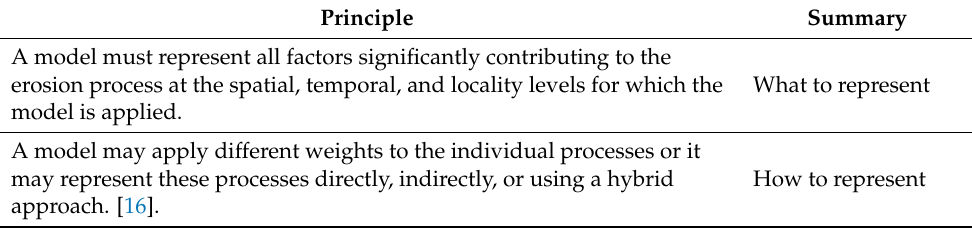
Table 1. Principles driving process representation in soil erosion models (modified after [15]).